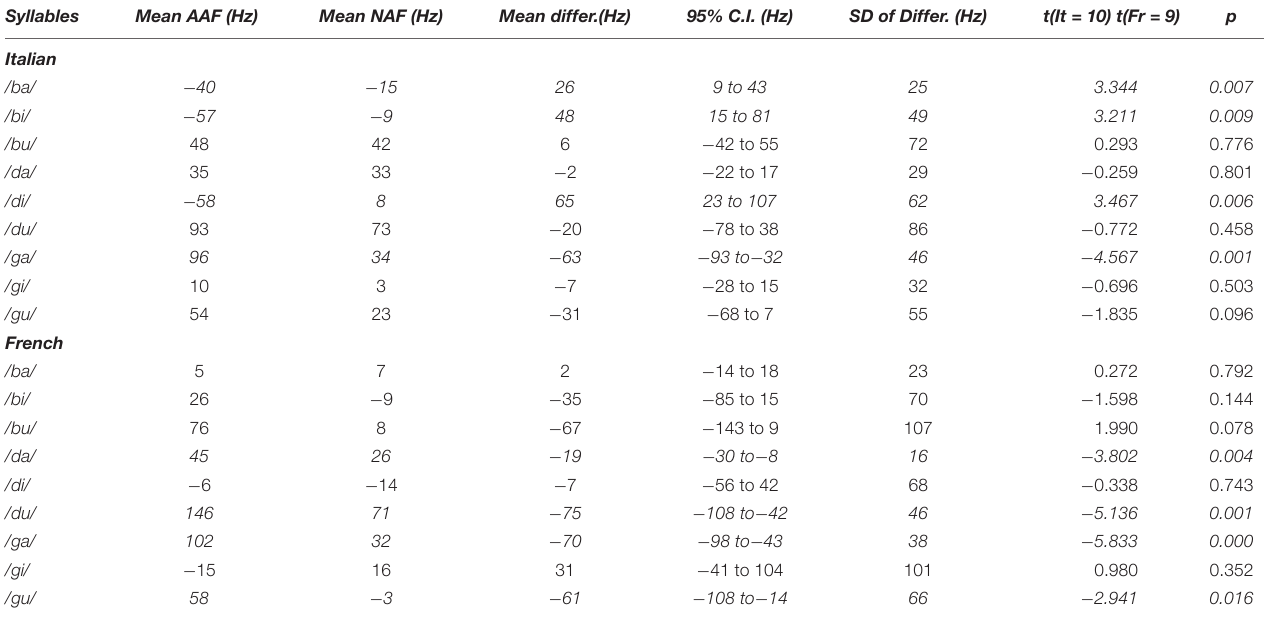
TABLE 7 | For each syllable and each language under NAF and AAF condition: Mean values (Hz) of F2 transition extent during the first tenth of the vowel duration ( (cid:49) F2 beg ), mean of the difference (Hz), 95% of the Confidence Interval (Hz), Standard Deviation of the Differences (Hz), t value (Degrees of Freedom), and p value (matched pairs t